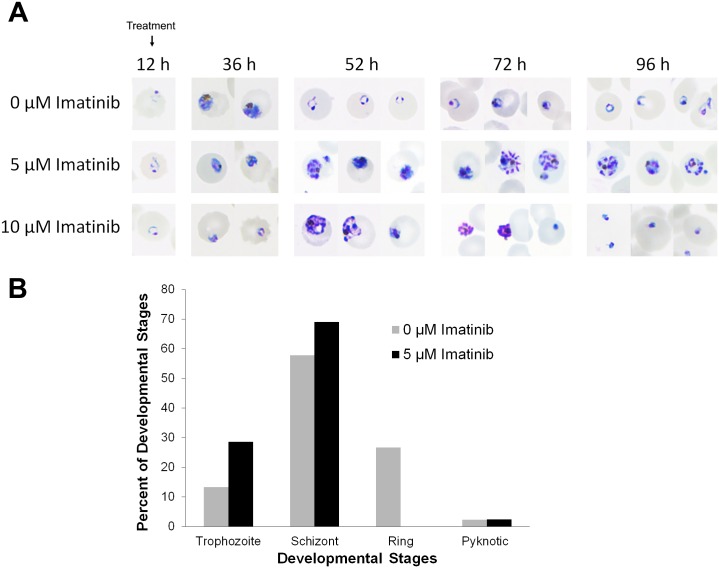
Effect of imatinib treatment on P. falciparum maturation and egress.Synchronized ring stage parasites (12 hours after parasite invasion) were either left untreated (top row) or treated with 5 μM (middle row) or 10 μM (bottom row) imatinib, and parasite morphology was assessed on blood smears by light microscopy at 12, 24, 36, 42, 44, 46, 48, 50, 52, 72, 96 hours after invasion using a Nikon Eclipse CI-L microscope, Plan Fluor 100X oil objective, Numerical Aperture 1.3 at room temperature equipped with a Nikon DS-Fi2 digital camera and NIS-Elements Basic Research acquisition software. (A) Representative images at the indicated time points are shown, focusing on morphology of individual infected cells to enable easier comparison. Note that at the 52 h time point, expected ring stage parasites are only seen in untreated cultures. (B) Quantitative analysis of 0 or 5μM imatinib treated malaria infected RBCs at 42 hpi.